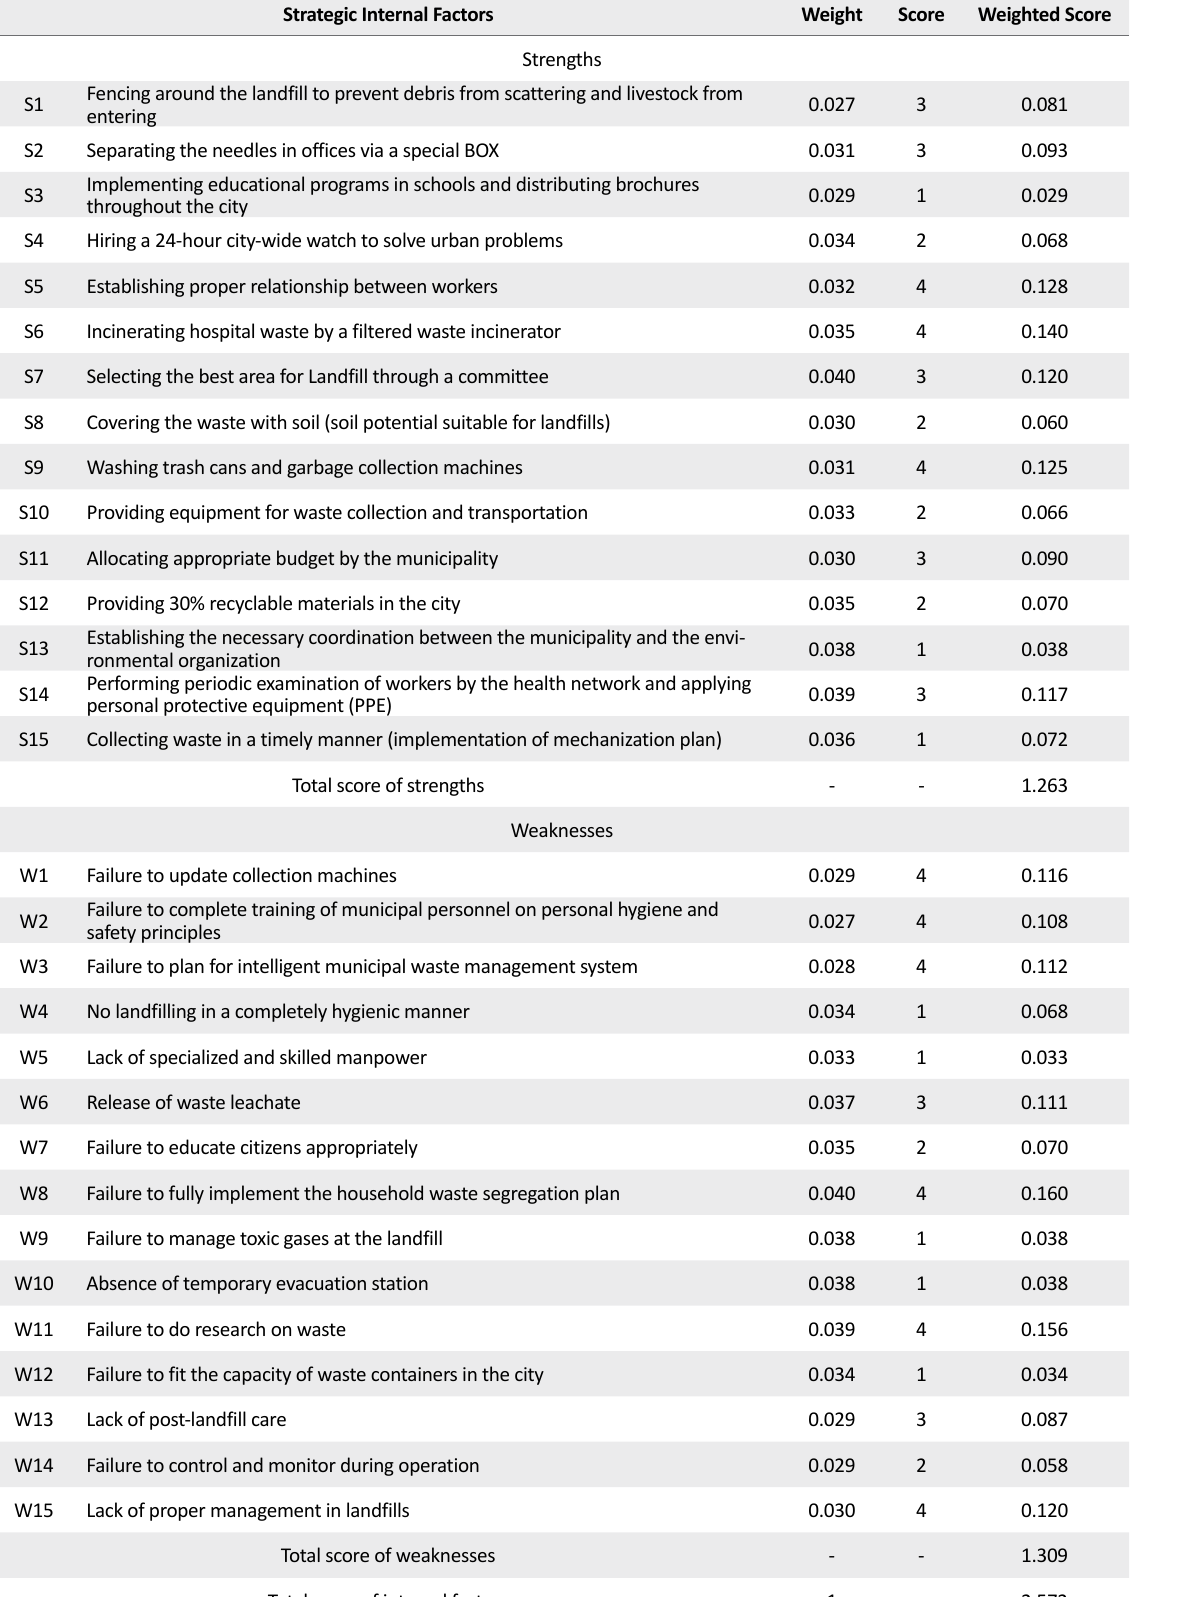
Table 2. Internal factor evaluation (IFE) matrix analysis of municipal waste management Strategic Internal Factors Weight Score Weighted Score